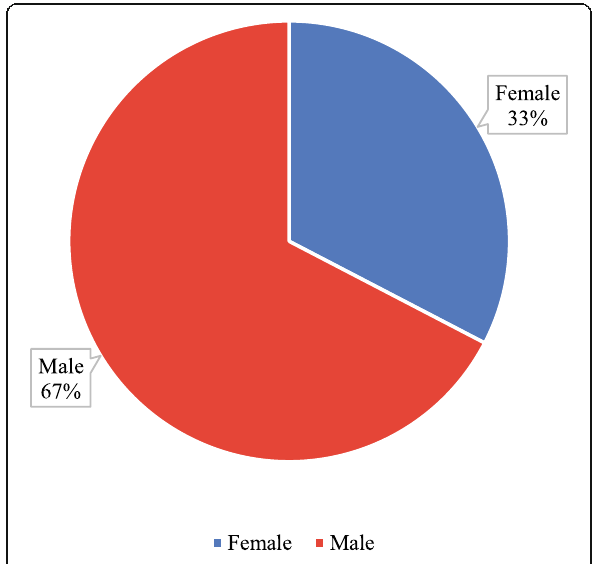
Fig. 1 Gender distribution of the participants